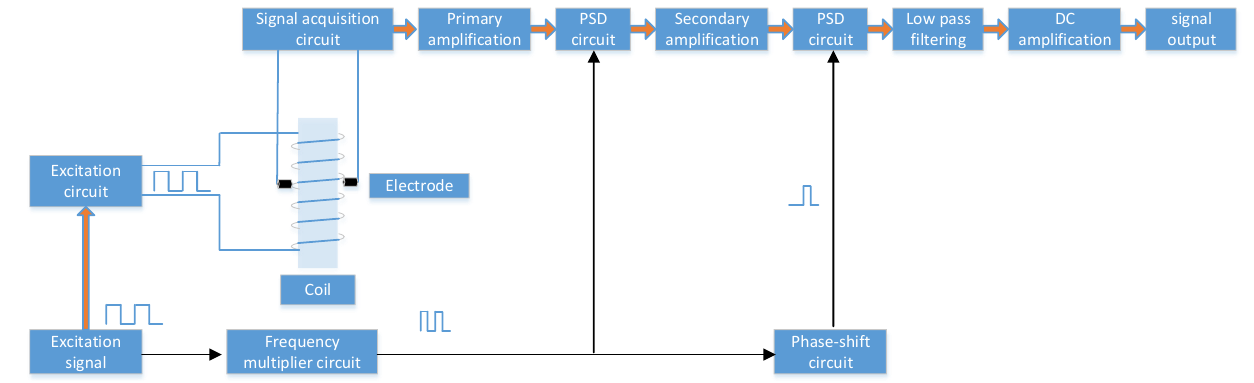
Figure 4. Structure diagram of a lock-in amplifier.